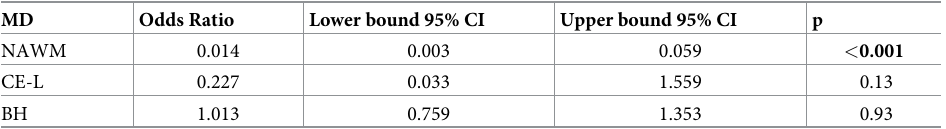
Table 4. Odds ratios MD. MD Odds Ratio Lower bound 95% CI Upper bound 95% CI p NAWM 0.014 0.003 0.059 < 0.001 CE-L 0.227 0.033 1.559 0.13 BH 1.013 0.759 1.353 0.93 Odds Ratios with the lower and upper bound of the 95%-confidence intervals and the p-values for mean diffusivity (MD) in normal-appearing white matter (NAWM), contrast enhancing lesions (CE-L) and black holes (BH) compared to FLAIR lesions (FLAIR-L) as reference category. Multinomial regression also included age, disease duration, EDSS and lesion